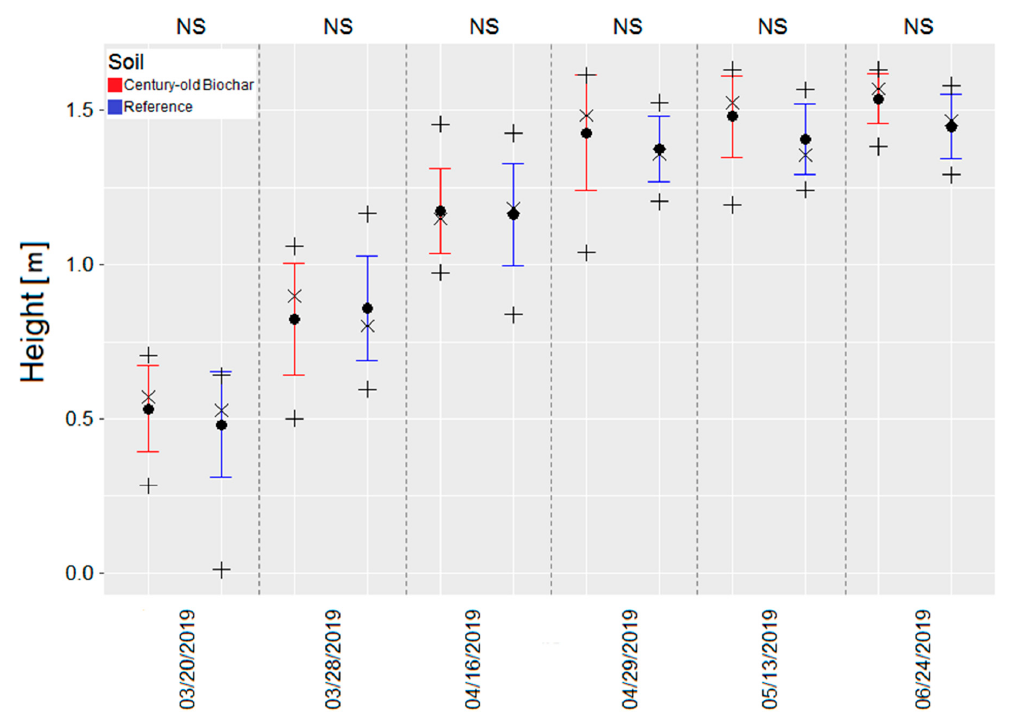
Figure 5. Comparison of the plant height of all the 11 century-old biochar plots (red) versus the 11 reference plots for each acquisition date. The black circle and cross represent the mean and median height, respectively. The error-bar presents the corresponding standard deviation. The bottom and top black pluses (+) indicate the minimum and maximum height, respectively. Outside of the plot, asterisks *, **, ***, and **** reveal the statistical levels of significance; the acronym NS stands for non-significant.